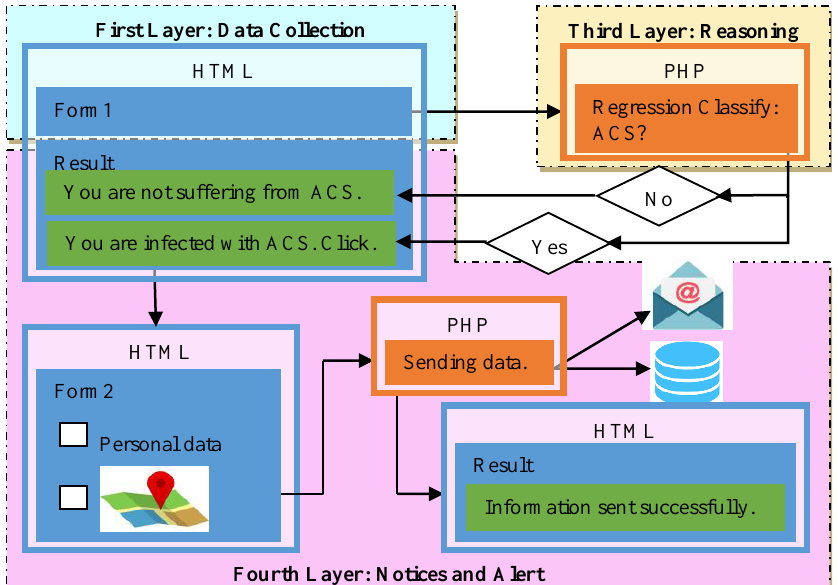
Figure 4. Proposed system architecture and component